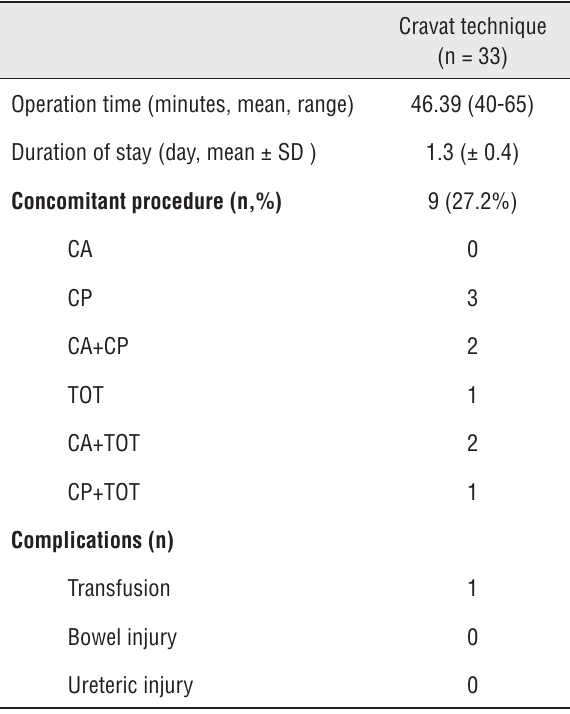
Table 2 - The operation characteristics of Cravat